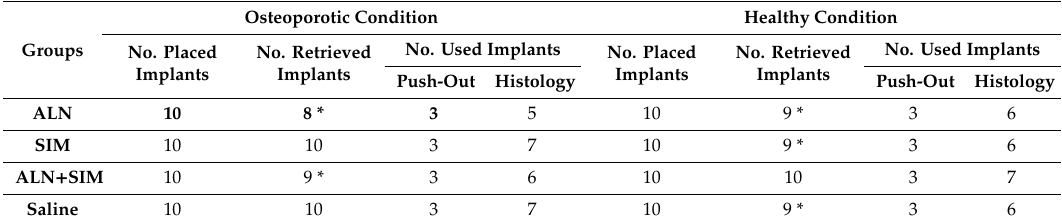
Table 1. Number of implants placed, retrieved, and used for push-out testing, histological evaluation, and histomorphometric measurements.